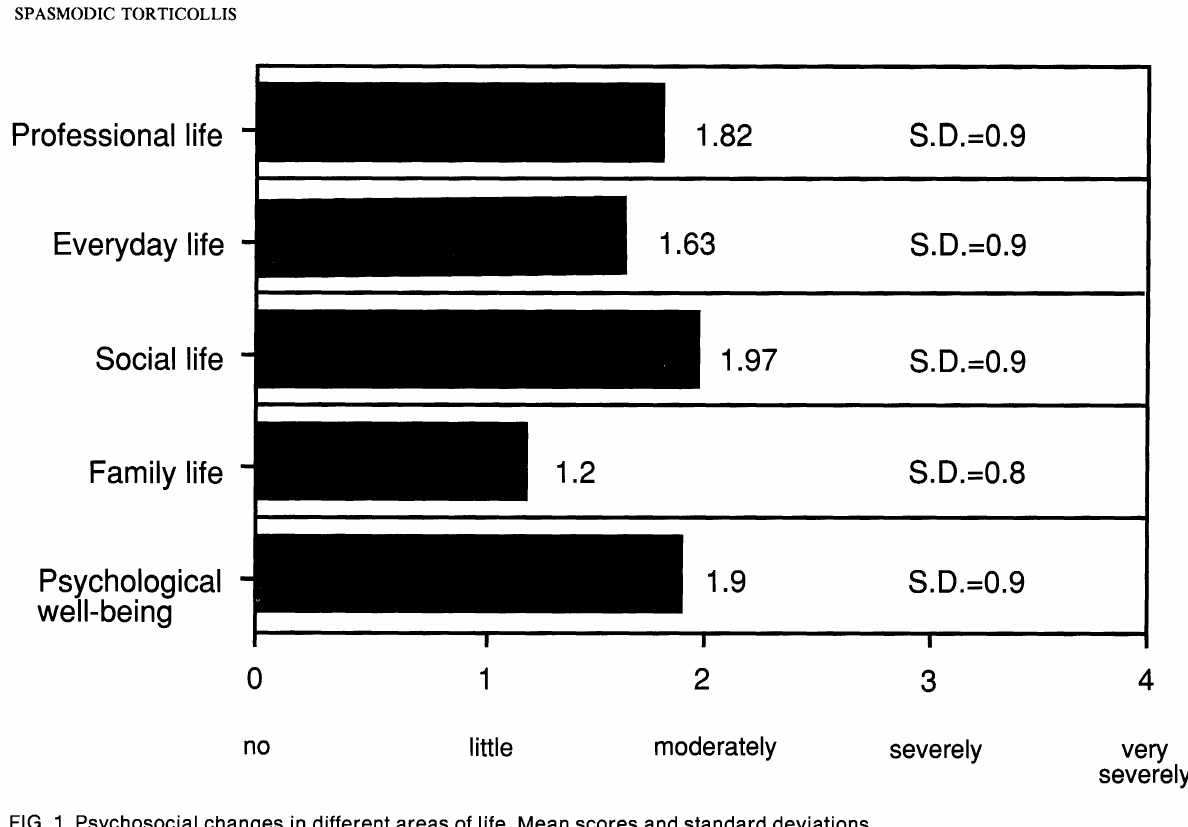
FIG. 1. Psychosocial changes in different areas of life. Mean scores and standard deviations.